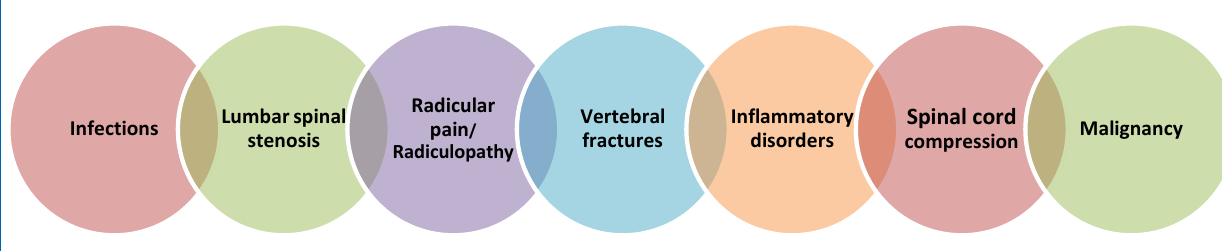
Figure 1: Causes of Back